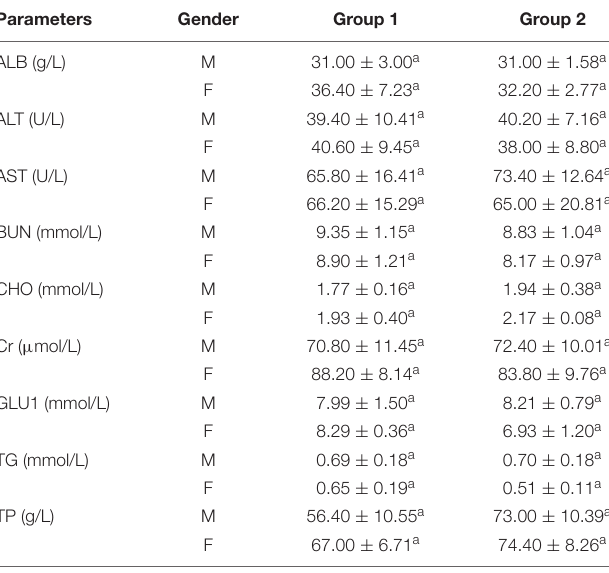
TABLE 5 | Serum biochemical data of control group and rats treated with the crude enzymes for 28 days. Parameters Gender